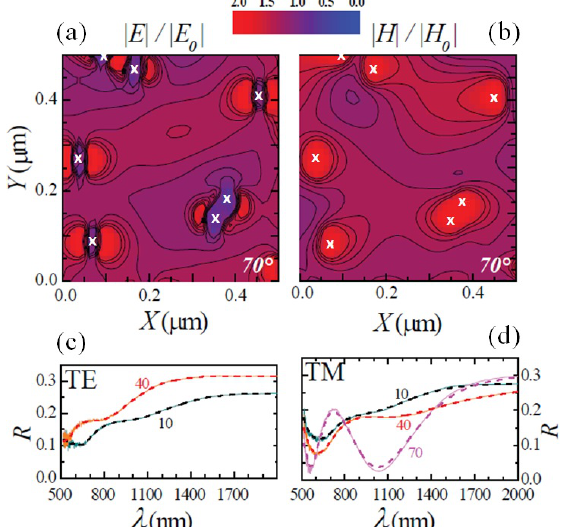
Figure 4. Numerical simulations of the near-field spatial distributions and reflectance. Normalized spatial distribution of the electric ( a ) and magnetic ( b ) field, calculated for the InAs NWs (density ≈ 30 NW/ µ m 2 , length 950 nm, diameter ≈ 45 nm) for TM-wave at 70 ◦ and at λ ≈ 1035 nm. The white crosses indicate the centers of the NWs. E 0 and H 0 represent the incident electric and magnetic field, respectively. ( c , d ) Calculated (dashed line) and measured (solid line) reflectance for the two